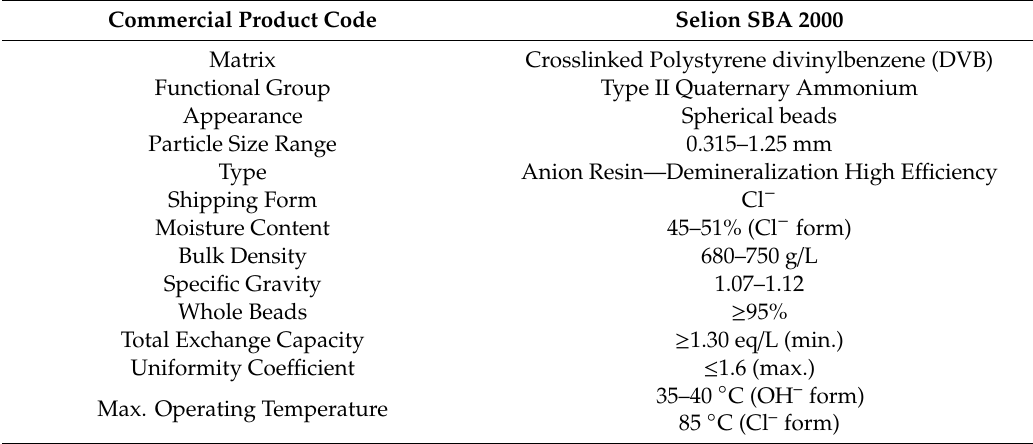
Table 1. Basic features and specifications of the resin